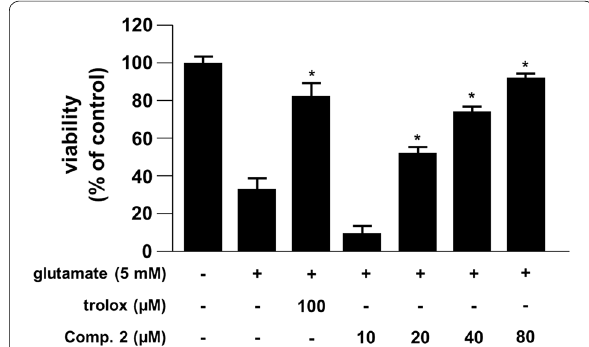
Fig. 2 Neuroprotective activity against cell death in HT22 cells treated by glutamate. Treatment of HT22 with 5 μM glutamate raised the formation of ROS. The error bars represent the mean three independent tests. * p < 0.05 compared with glutamate‑treated group. Positive control, trolox